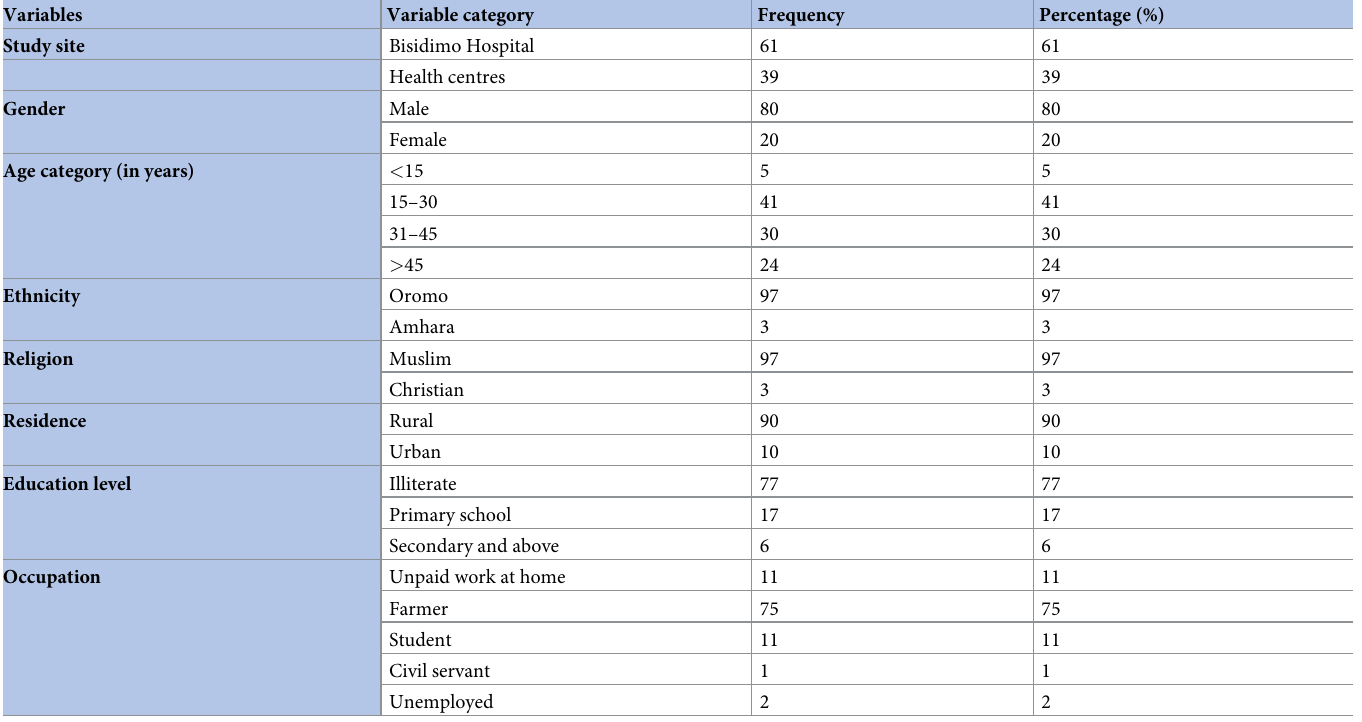
Table 1. Socio-demographic characteristics of participants included in the study, Eastern Ethiopia, from January to February 2019 (number = 100).